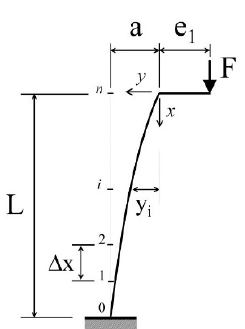
Figure 3. Cantilever column for application of the finite difference